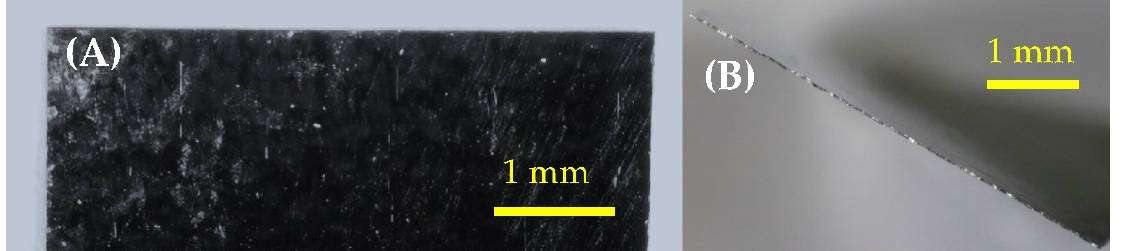
Figure 2. Microscopic images of the edge/corner profiles ( A ) and edge ( B ) of a mechanically sheared rectangular sensor that has been annealed. The images feature the 5 mm edge of a 12.7 × 5 mm sensor.